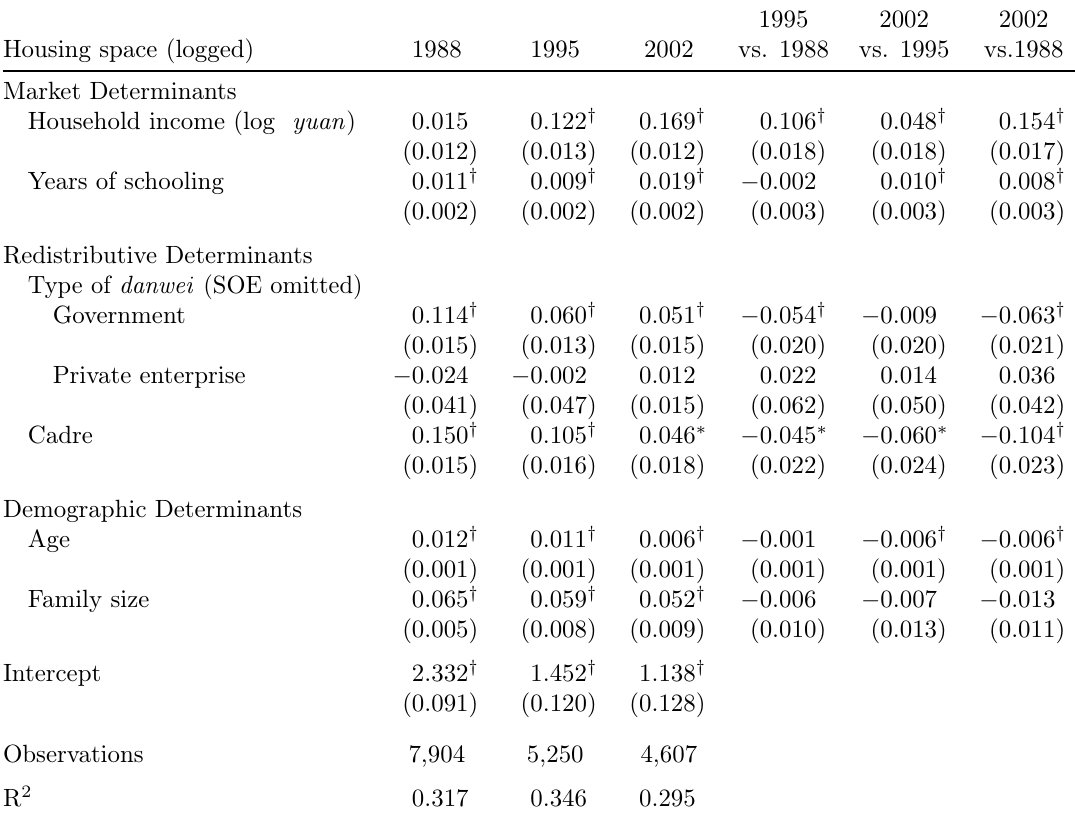
Table 5: Changing Determinants of Housing Space with Regional Fixed